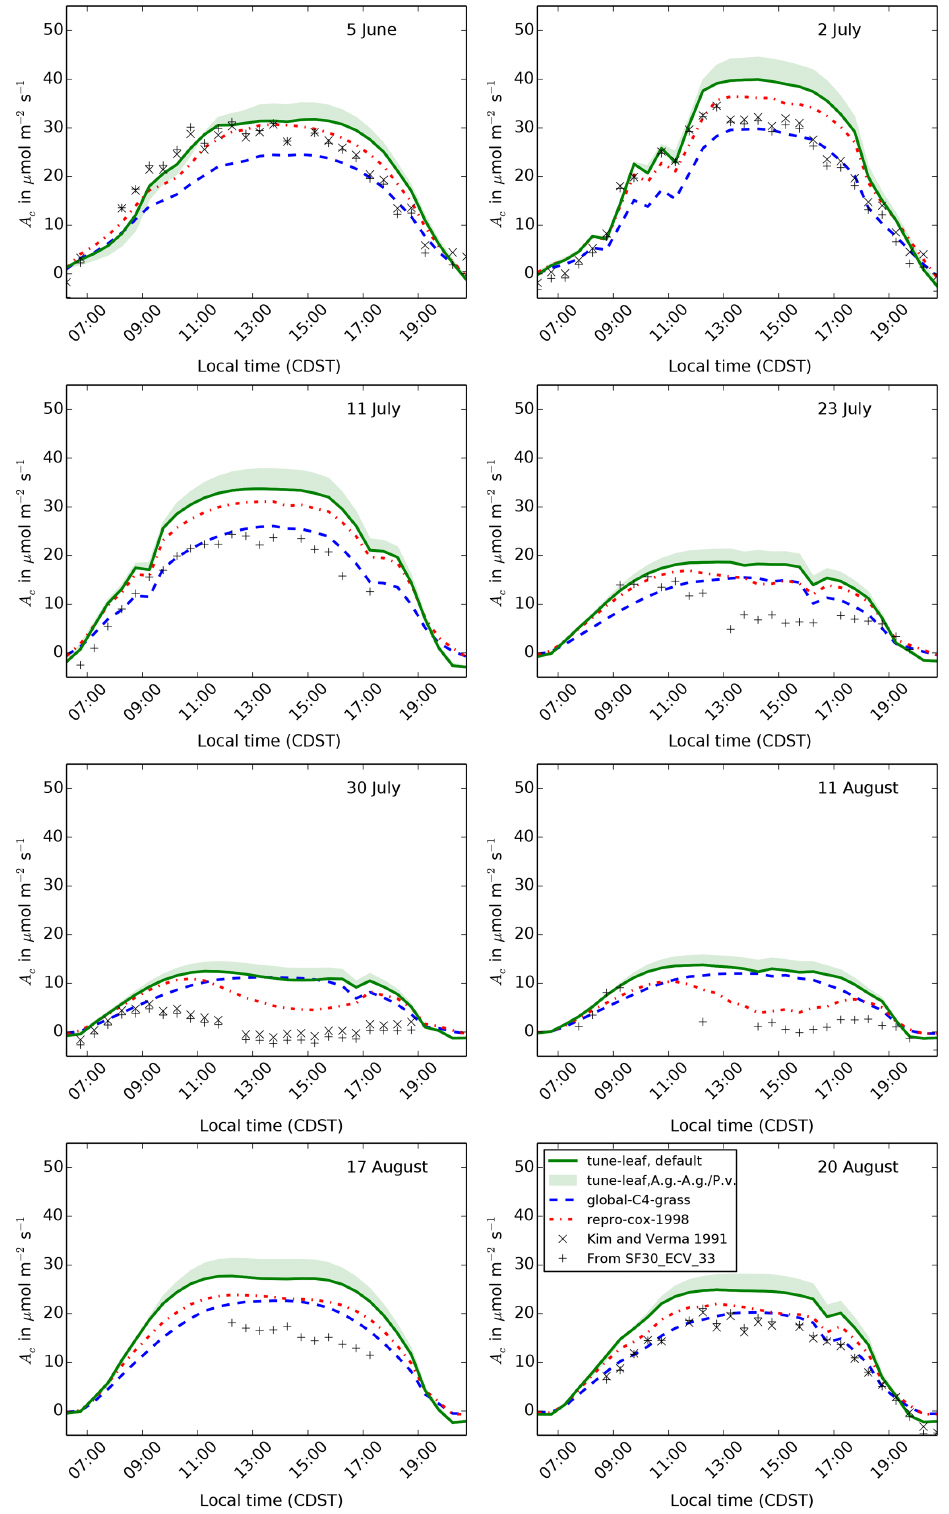
Figure 10. The diurnal cycle of net canopy assimilation A c at site 4439 in the FIFE area for 8 days in 1987: 5 June (early growth), 2 and 11 July (peak growth), 23 July, 30 July and 11 August (dry period), and 17 and 20 August (early senescence). Green band shows uncertainty from fitting plant parameters to A. gerardii compared to fitting to both A. gerardii and P. virgatum